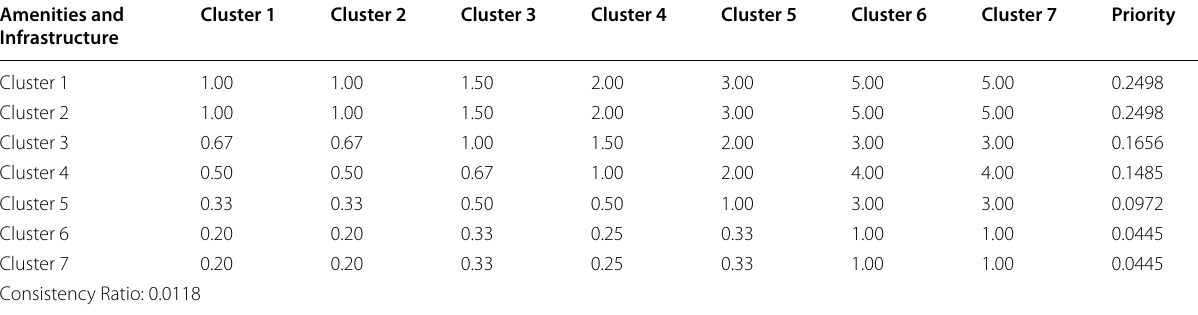
Table 11 Pair Wise Comparison Matrix of Alternatives with respect to the Availability of Amenities and Infrastructure